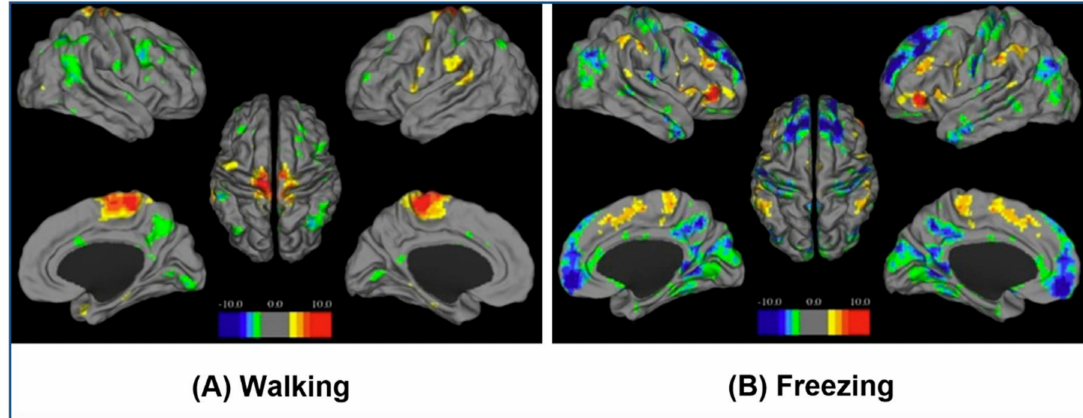
Figure 3. Distinct Blood-oxygen-level dependent (BOLD) patterns observed during walking and episodes of freezing with VR based method. ( A ) Whole brain statistical parametric mapping (SPM) maps showing cortical activation pattern (represented as contrast values from SPM analysis) comparing “walking” with observing showing bilateral activation of sensorimotor regions known to mediate movement of the lower limbs (statistical map threshold significant at p < 0.001; false discovery rate corrected to p < 0.05). ( B ) Whole brain statistical parametric mapping (SPM) maps showing pattern of cortical activation and deactivation (represented as contrast values from SPM analysis) present during freezing episodes ( p < 0.001; false discovery rate corrected to p < 0.05). Periods of freezing demonstrated marked bilateral activation in the pre-supplementary areas, the motor cortices, dorsolateral and ventrolateral prefrontal cortices, as well as posterior parietal regions. In contrast, there was marked bilateral deactivation of the frontopolar cortices and the precuneus. Upper left corner: Right hemisphere lateral, upper right corner: Left hemisphere lateral, lower left corner: Left hemisphere medial, lower right corner: Right hemisphere medial, and center: Both hemispheres dorsal. Adapted from the Journal of Clinical Neuroscience Shine, J.M., Ward, P.B., Naismith, S.L., Pearson, M., Lewis, S.J. (2011). Utilizing functional magnetic resonance imaging (fMRI) to explore the freezing phenomenon in Parkinson’s disease. 18(6), 807–810. Copyright © 2020 Elsevier Ltd. All rights reserved, with permission from Elsevier. Reference